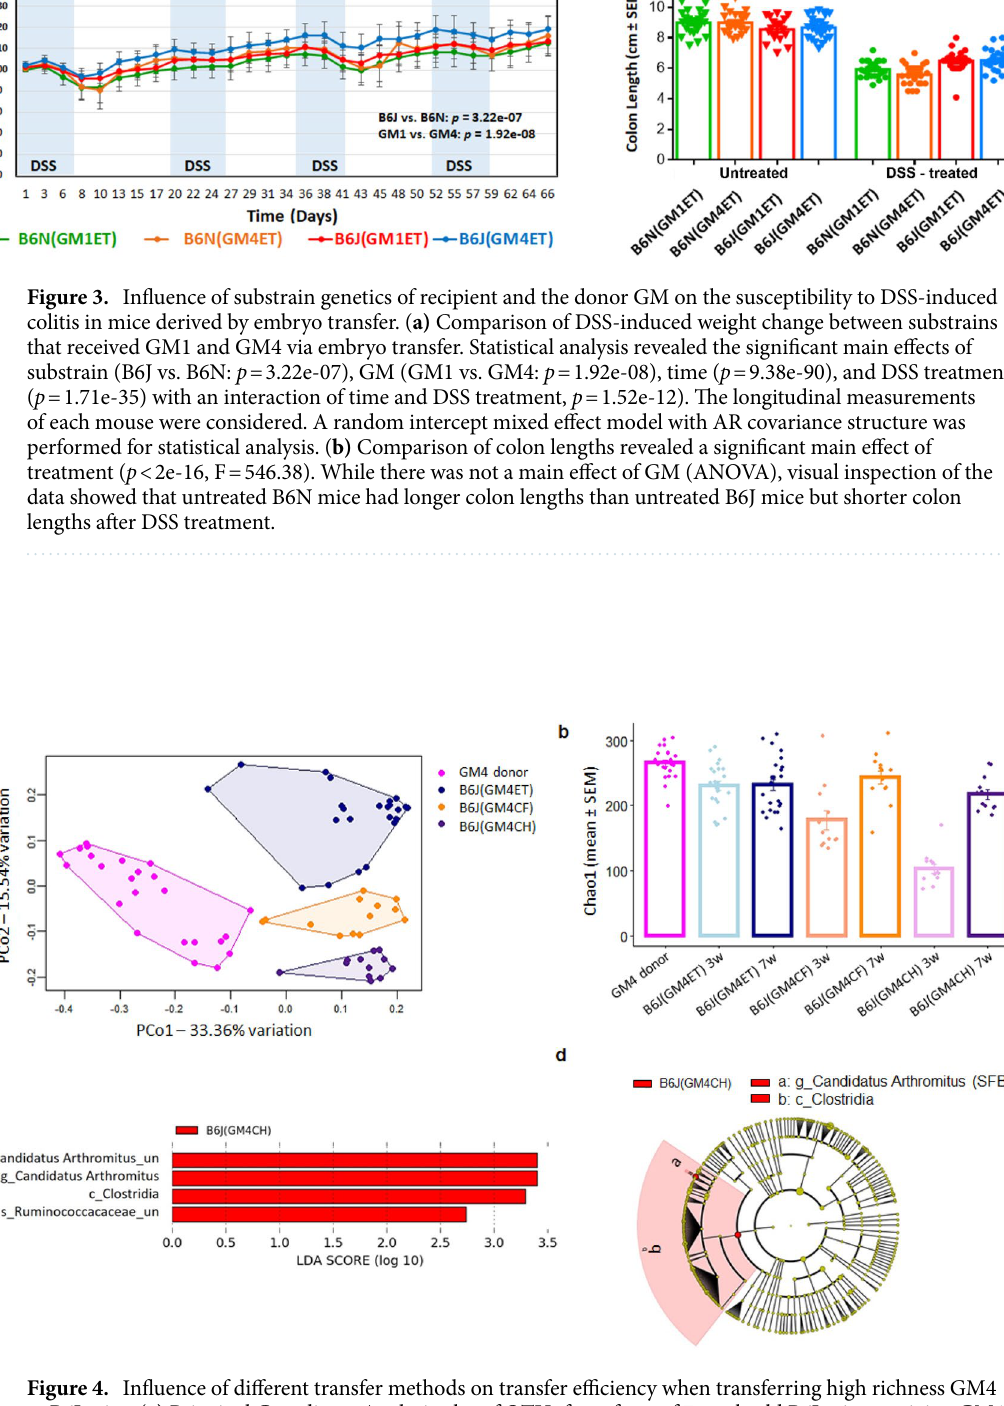
Figure 4. Influence of different transfer methods on transfer efficiency when transferring high richness GM4 to B6J mice. ( a) Principal Coordinate Analysis plot of OTUs from feces of 7-week-old B6J mice receiving GM4 via embryo transfer (ET), cross fostering (CF), and co-housing (CH) as compared to their CD-1(GM4) donors showed a main effect of transfer method ( p = 0.001; F = 21.05, Bray–Curtis). ( b) Statistical analysis (ANOVA) of the Chao-1 index of data from the same B6J mice also showed a main effect of transfer method at both 3 weeks ( p = 2.2e-16; F = 69.897) and 7 weeks ( p = 6.2e-4; F = 6.49) with the difference between transfer method and donor dam increasing from CH > CF > ET at 3 weeks. ( c) Linear discriminant analysis effect size (LEfSe) analysis and ( d ) Cladogram show compositional differences and taxa that were significantly overrepresented in each group. Cladogram circles represent the different taxonomic levels from phylum (innermost circle) to species (outermost circle). Annotation represents p_ phylum, c_ class, o_ order, f_ family, g_ genus, or s_ species from the inside to the